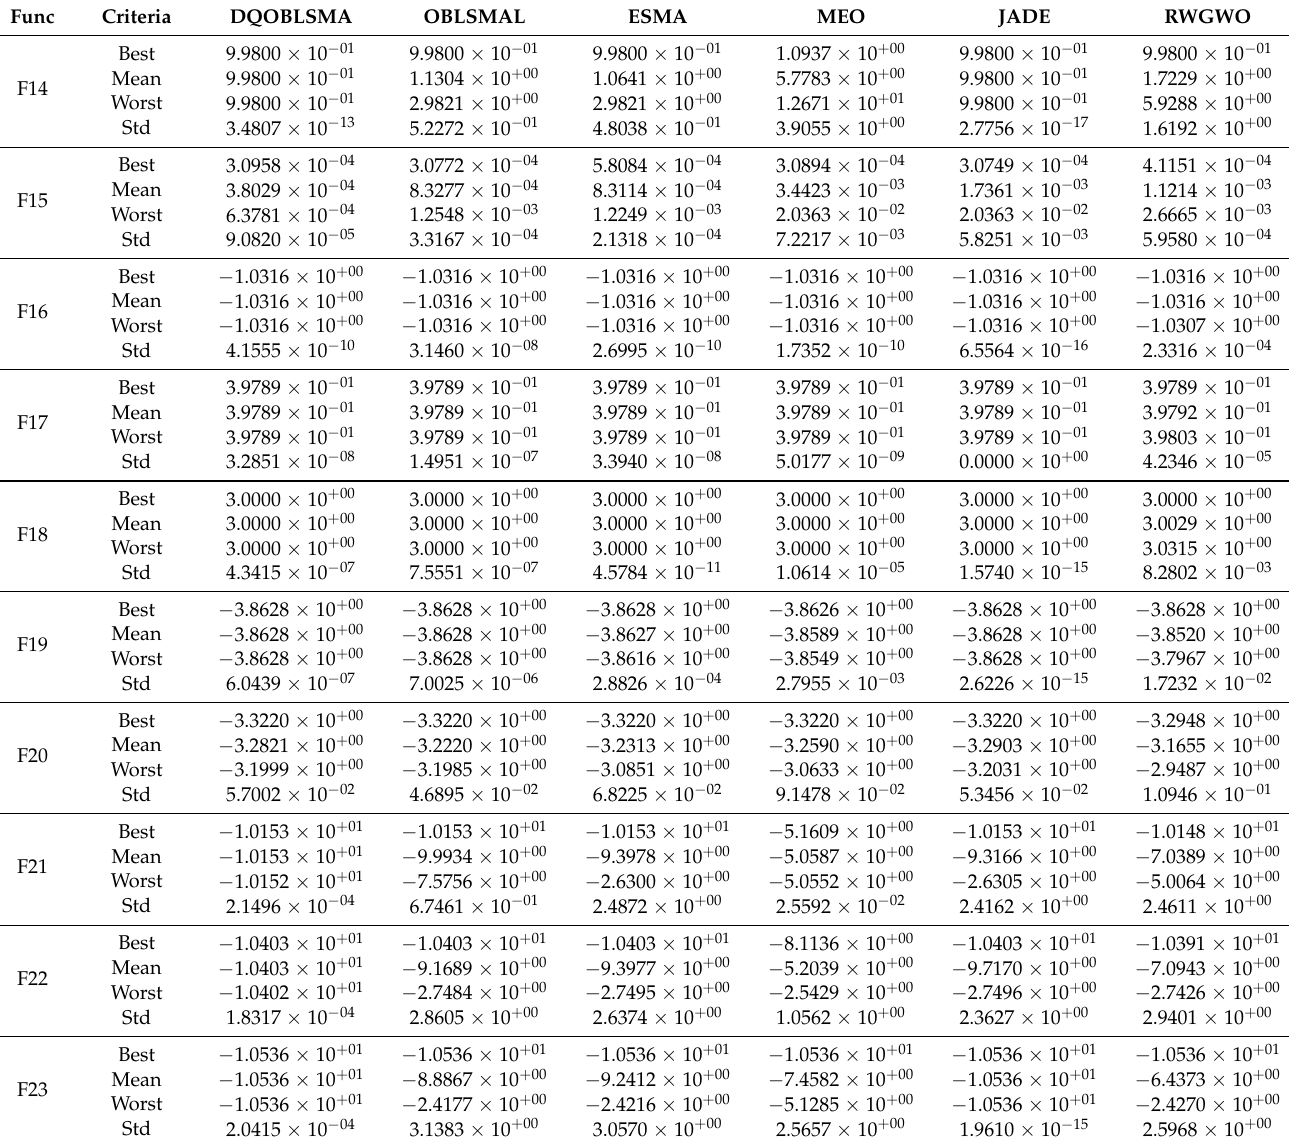
Table 8. Results of fixed-dimension multi-modal benchmark